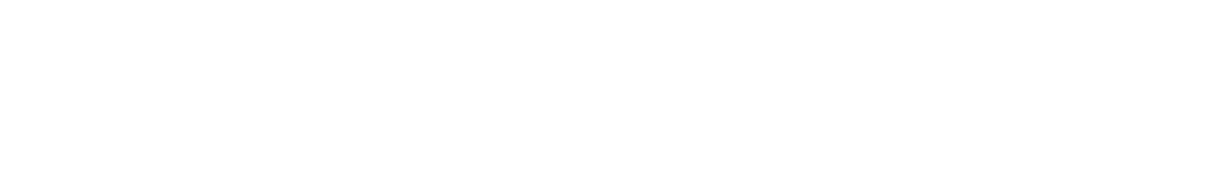
Frontiers in Virtual Reality |